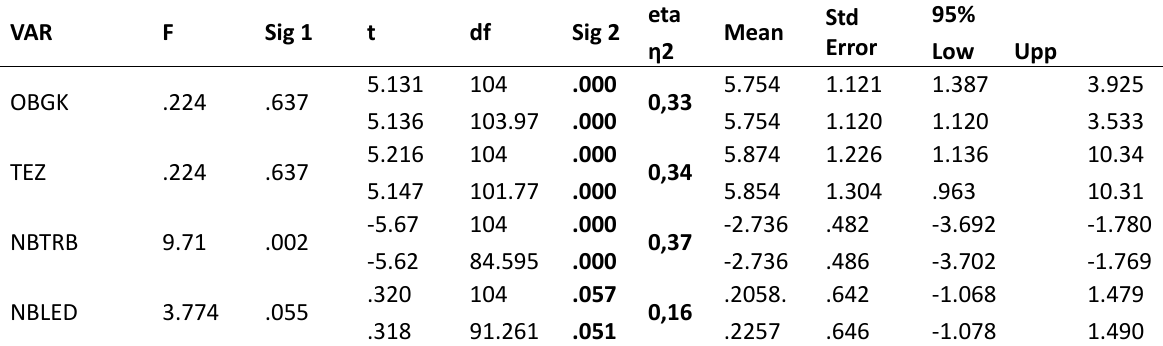
Table 2. Morphological Characteristics, T-test for Independent Groups VAR